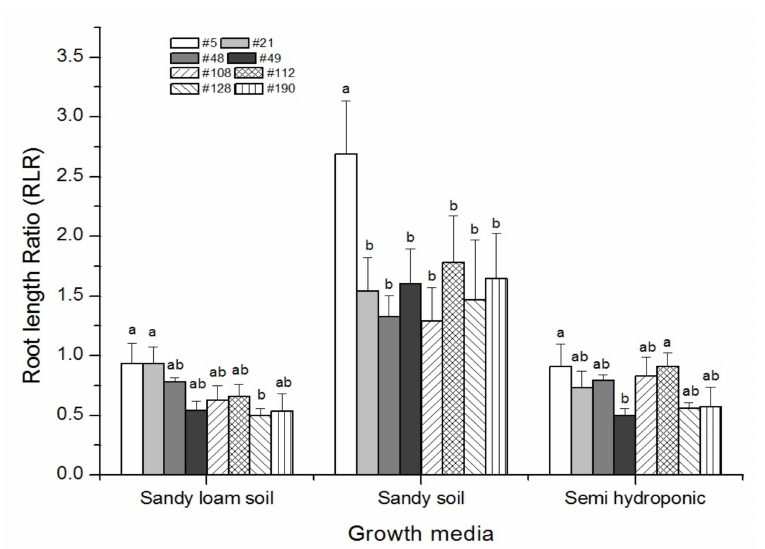
Figure 5. Root length ratio (root length in the top 20 cm section over the length of the remaining roots) of eight barley genotypes grown in sandy loam soil, sandy soil and semi-hydroponically. These eight genotypes were selected out of 189 barley genotypes grown in the semi-hydroponic system for 30 days after transplanting. Bars with the same significance letter in the given growth medium are not significantly different according to the Tukey test ( p ≤ 0.05). Data are means ( n = 3) + standard error of